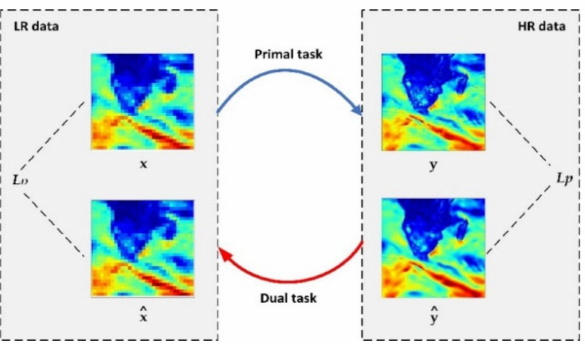
Figure 5. The illustration of dual learning scheme for SSW downscaling, which contains a primal task for super-resolution and a dual task for downsampling, thus forming a closed-loop. The detailed configuration for the generator network, taking the downscaling 16 ×